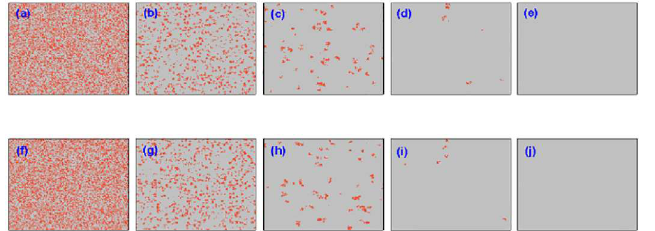
Fig 5. Characteristic snapshots of cooperators and defectors on two independent lattices for a fixed temptation to defect ( b = 1.07) starting from an initial strategy distribution. In the upper row, from panel (a) to (e), snapshots are taken from one lattice at the time step 1, 10, 100, 200, 1000, respectively; Similarly, in the lower row, we provide the snapshots on the other lattice at the same time step. The orangedots represent the cooperators, and the light gray dots denotethe defectors. The system setup is assumed to be L = 200, MCS = 5 × 10 4 and κ = 0.1 and the tunableparameter α =